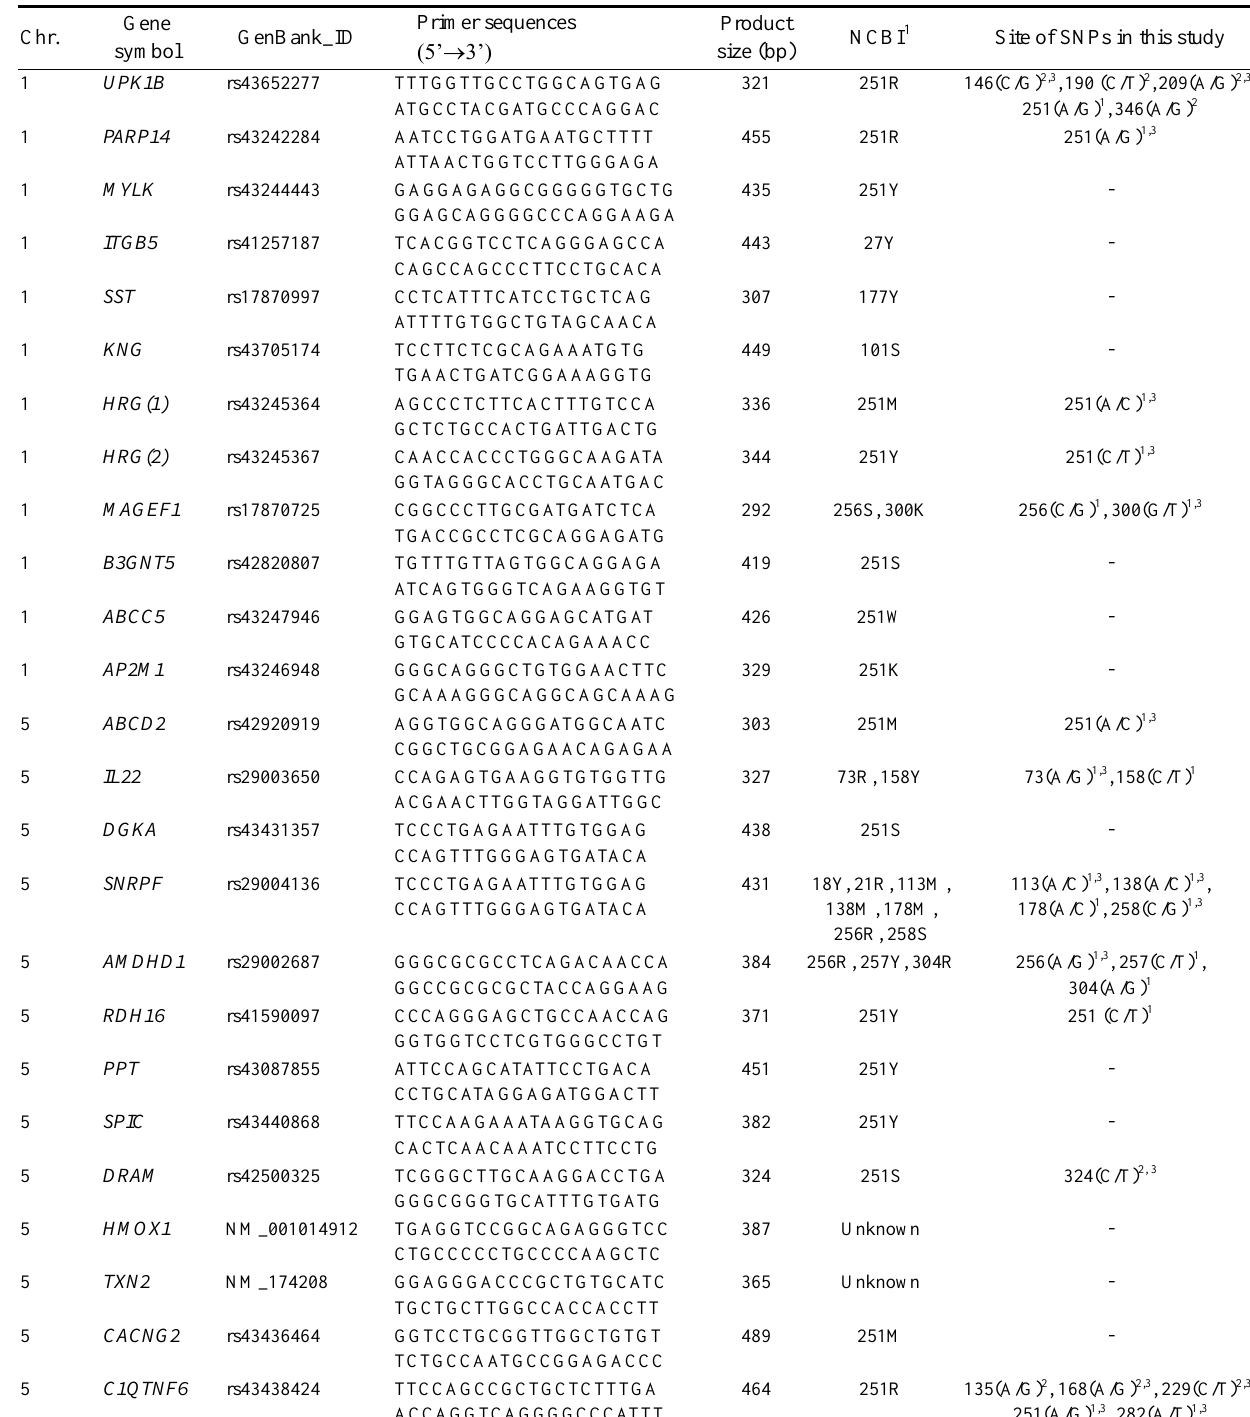
Table 2. Identification of SNPs in MCA/MSU and Korean cattle